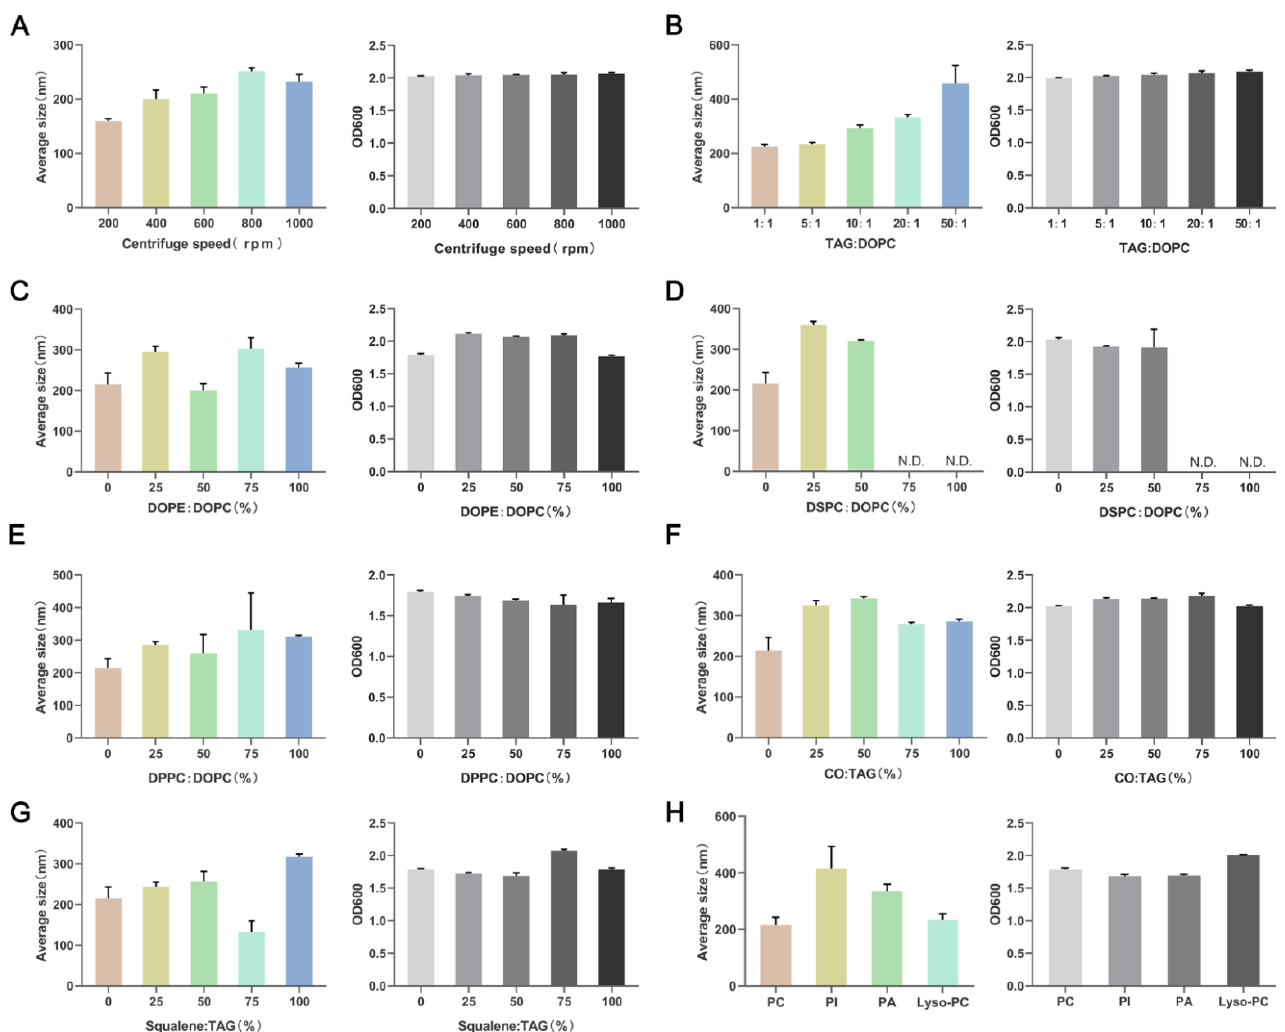
Figure 2. Concentration (OD 600) and size (average size) of lipid nanoparticles prepared under different conditions. ( A ) Concentration (OD 600) and size (average size) of NLPs under different stirring speeds. ( B ) Concentration (OD 600) and size (average size) of NLPs generated with different ratios of DOPC and TAG. DOPC, 1,2-di(9Z-octadecenoyl)-sn-glycero-3-phosphocholine; TAG, triacylglycerol. ( C ) Concentration (OD 600) and size (average size) of NLPs generated with different ratios of DOPE and DOPC. DOPE, 1,2-Dioleoyl-sn-glycero-3-phosphoethanolamine. ( D ) Concentration (OD 600) and size (average size) of NLPs generated with different ratios of DSPC and DOPC. DSPC, 1,2-Distearoyl-sn-glycero-3-phosphocholine. ( E ) Concentration (OD 600) and size (average size) of NLPs generated with different ratios of DPPC and DOPC. DPPC, 1,2-dipalmitoyl-sn-glycero-3-phosphocholine. ( F ) Concentration (OD 600) and size (average size) of NLPs generated with different ratios of CO and TAG. CO, Cholesterol. ( G ) Concentration (OD 600) and size (average size) of NLPs generated with different ratios of SQ and TAG. SQ, Squalene. ( H ) Concentration (OD 600) and size (average size) of NLPs generated with different ratios of multiple phospholipid fractions. The proportion of PI, PA and Lyso-PC to total phospholipids was 16.7%. PI, l-a-phosphatidylinositol; PA, phosphatidic acid; Lyso-PC, 1-hexanoyl-2-hydroxy-sn-glycero-3-phosphocholine. Cholesterol is a common neutral lipid in LDs. By gradually replacing TAG with cholesteryl oleate (CO), the particle size of NLPs was maximized, and the yield increased when the cholesterol ratio was 50%. Further increasing the CO ratio did not increase the par- ticle size of NLPs but even decreased it, and the yield was also slightly reduced (Figure 2F). Similarly, we added squalene (SQ) to the NLPs, and when the SQ ratio was increased,